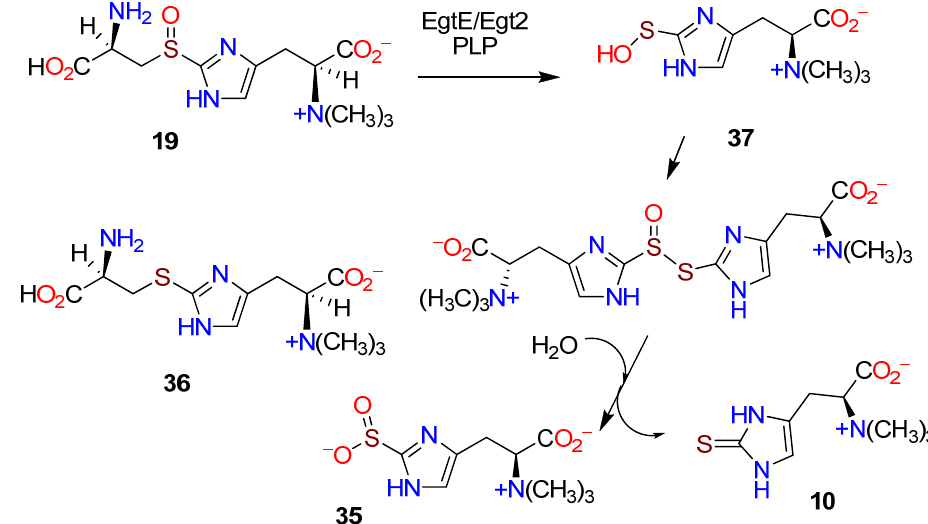
Figure 7. Incubation of EgtE with the thioether 36 and the sulfoxide 19 (adapted from ref. [108]).